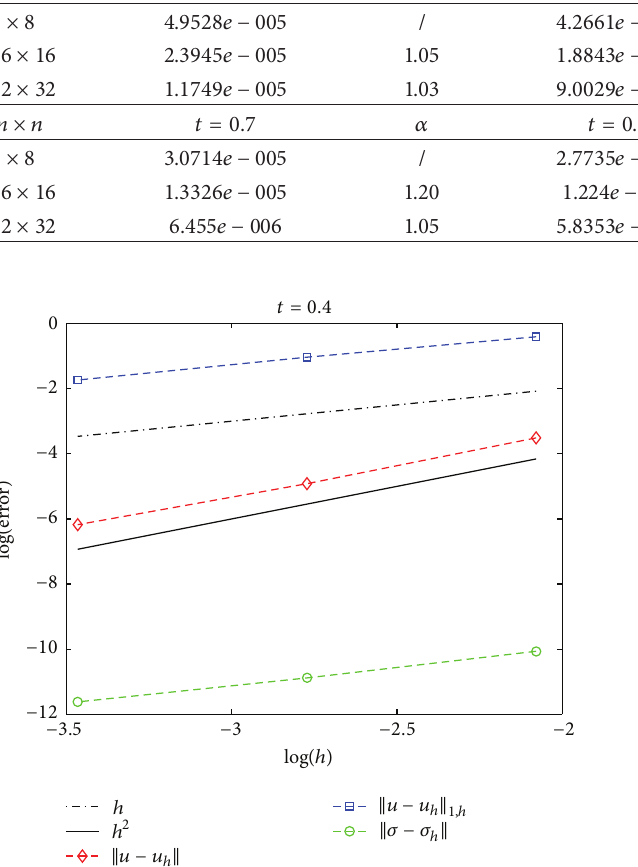
Figure 3: Errors at 𝑡 = 0.8 .